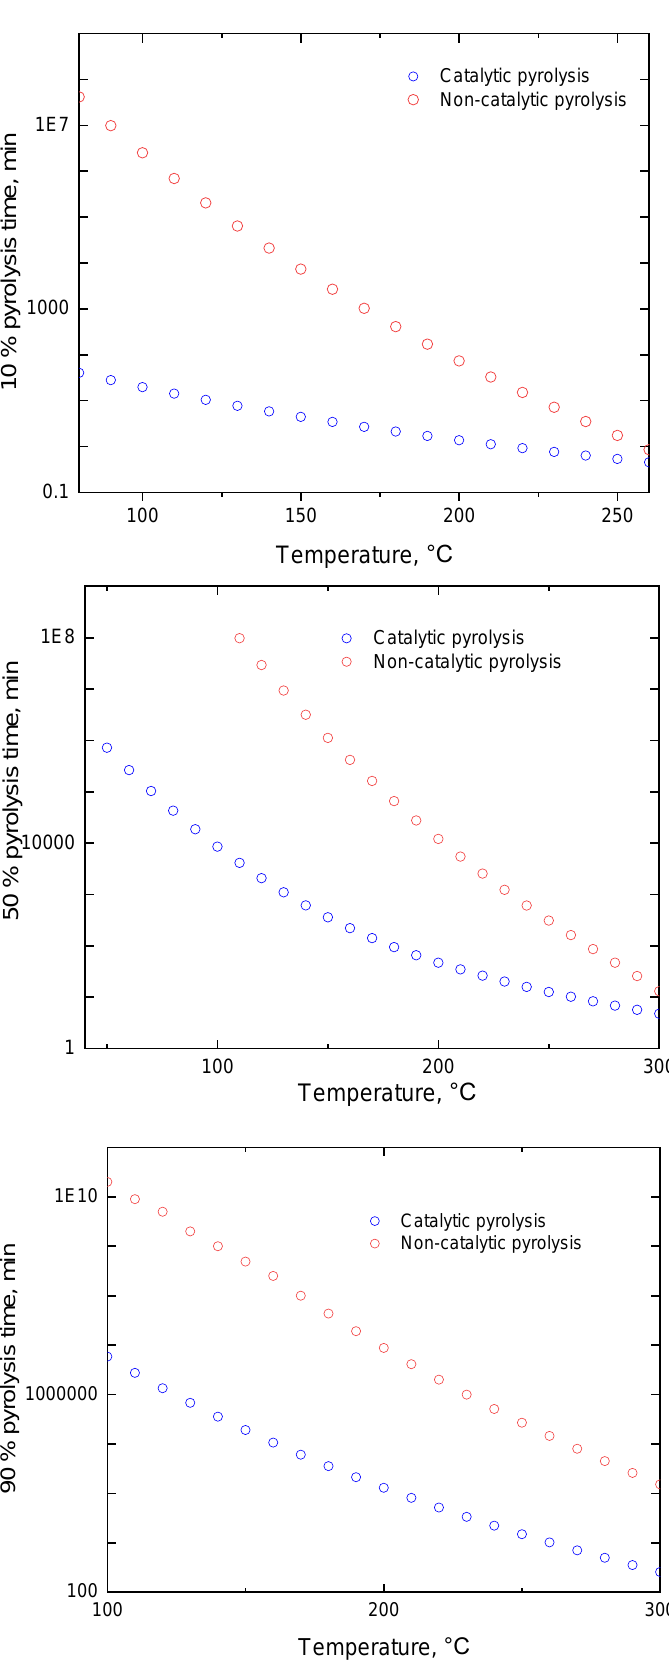
90% pyrolysis conversions.